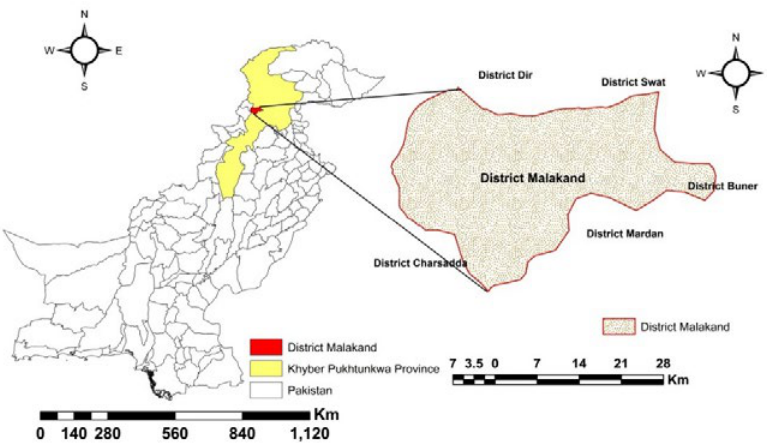
Fig. 1. Geographic location of the study area in district Malakand of Fig. 1: Geographic location of the study area in district Malakand of Pakistan